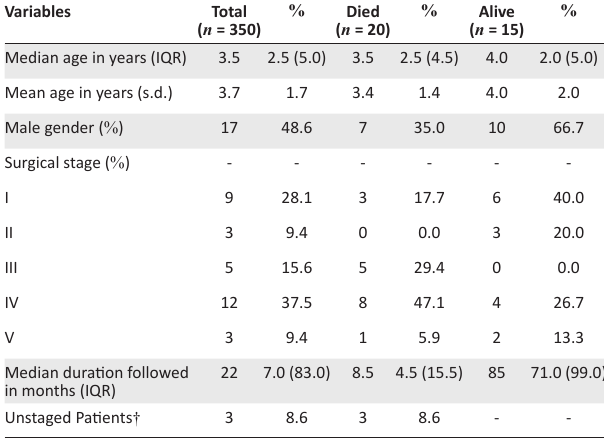
TABLE 1: Demographic and clinical characteristics of children treated with an SIOP using an adapted protocol in Cameroon between 2007 and 2012 ( N = 35).